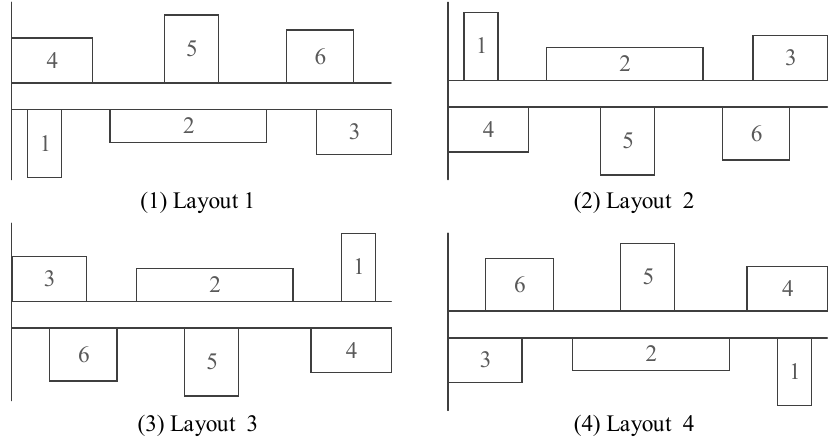
Figure 2. Four symmetry layouts with the same material handling cost.